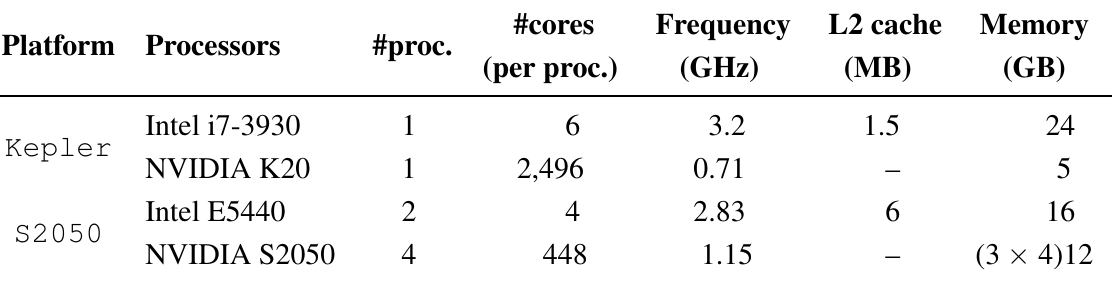
Table 1. Hardware platforms employed in the experimental